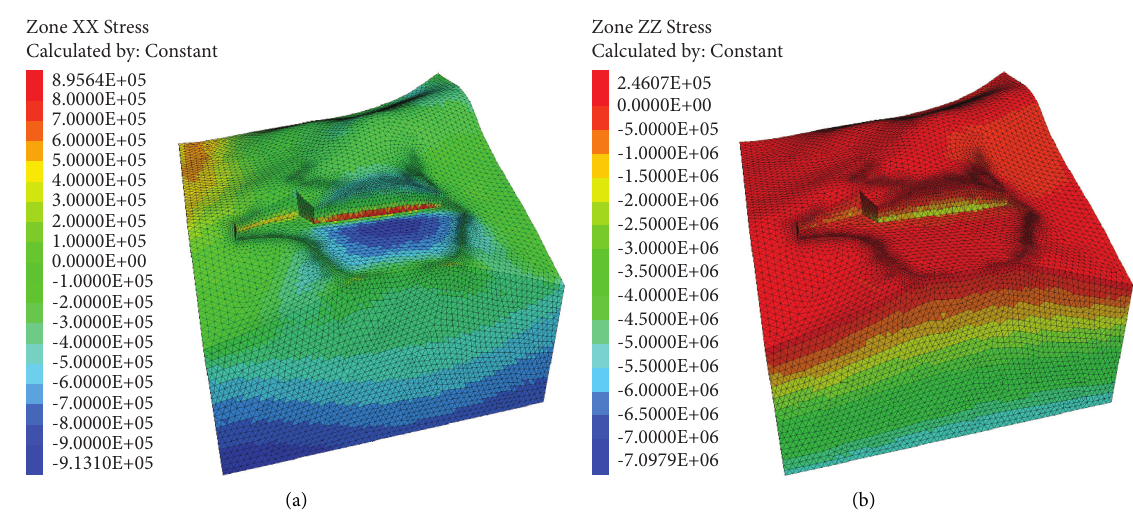
Figure 9: Stress nephogram after second excavation. (a) X -direction stress nephogram and (b) Z -direction stress nephogram.